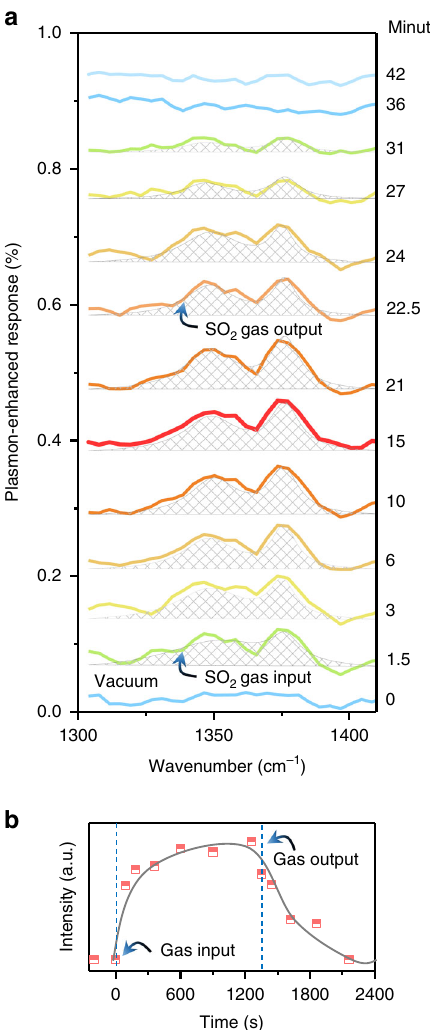
Fig. 2 Real-time gas identi fi cation. a Real-time plasmon-enhanced rotational-vibrational mode response of SO 2 during a full gas enter-exit cycle (data extracted from the extinction measurements reported in Supplementary Figure 10). Spectra were recorded at the times indicated on the right. b Kinetic plot of plasmon-enhanced SO 2 signal intensity, de fi ned as the integrated peak area in a as the SO 2 gas enters and exits